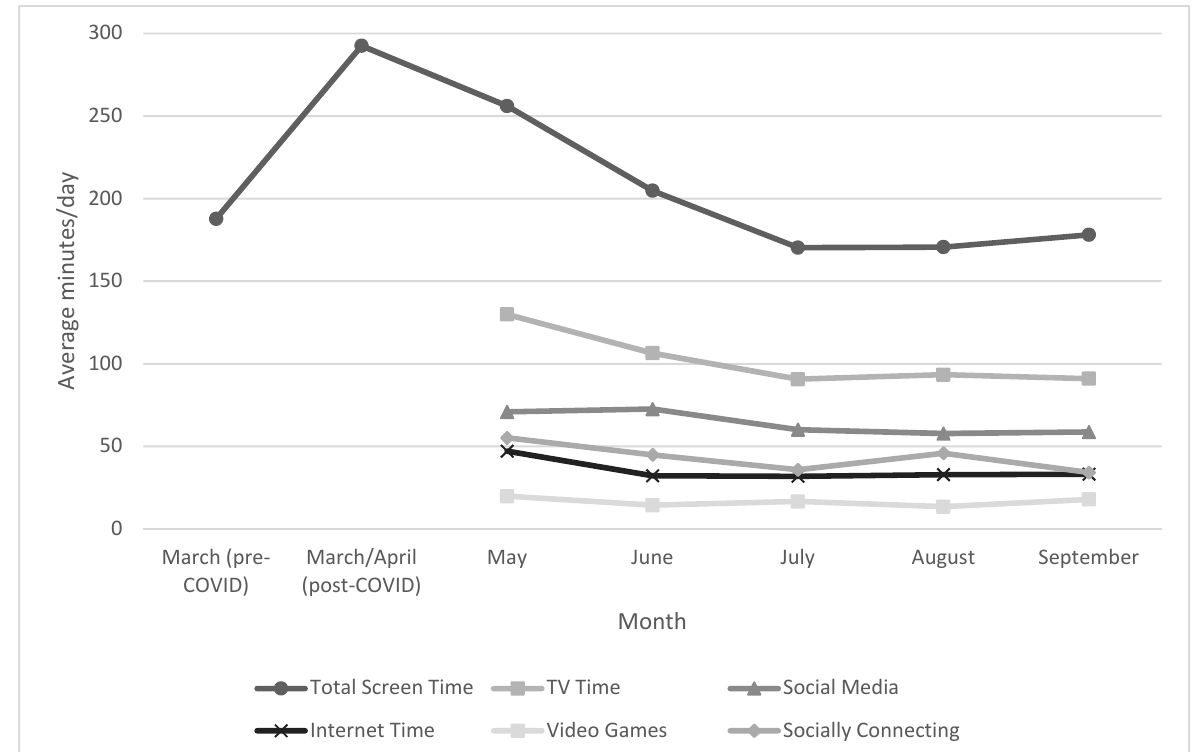
Figure 1. Sedentary behaviours by month.